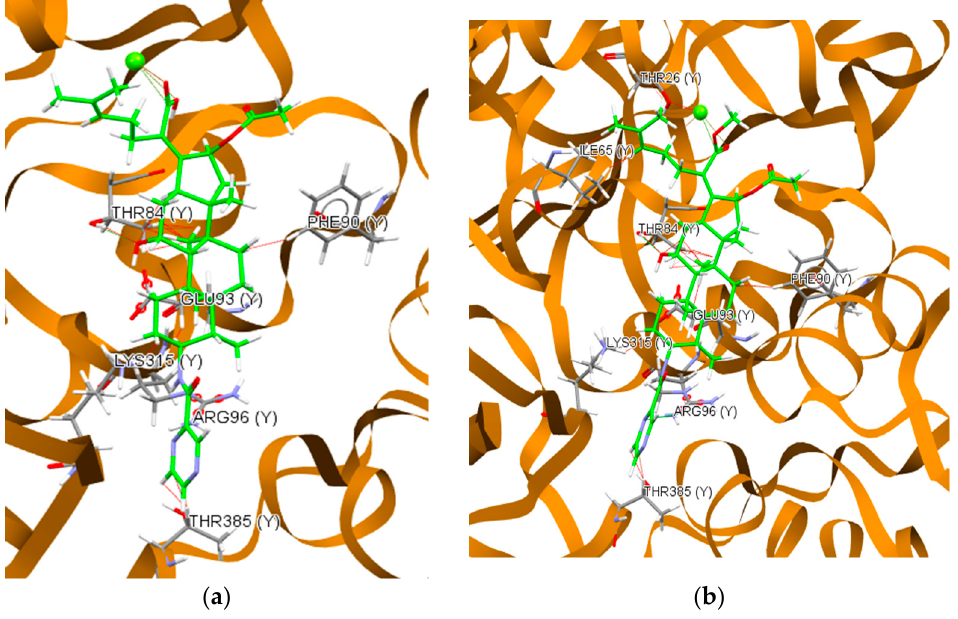
Figure 7. Complex of elongation factor (Ef-G) with ligands 3 ( a ) and 4 ( b ). Comparison of the results of molecular docking for ligands 5 , 6 , 11 , 19 , 20 , 21 , and 22 demonstrates an increase in the weight coefficients of hydrogen bond formation energy (PLP part.hbond) with increasing number of nitrogen atoms in the substituent in ring A (Table S3).